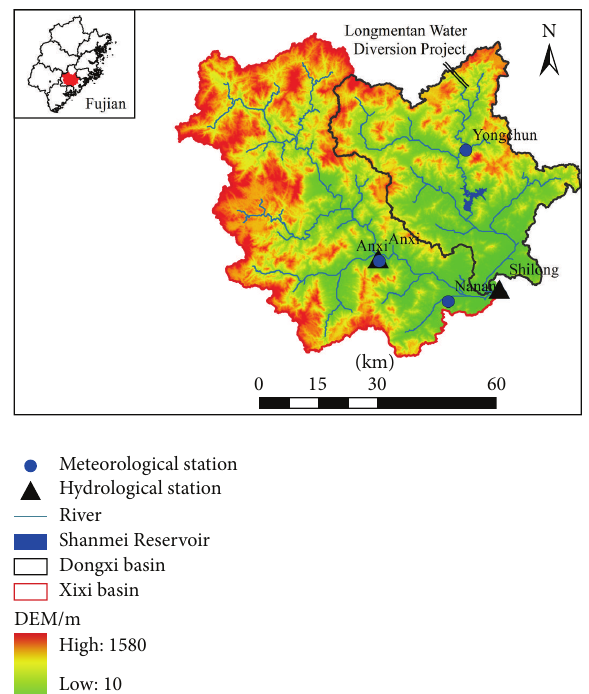
Figure 1: Location of the study area and hydrologic and meteoro- logical stations.